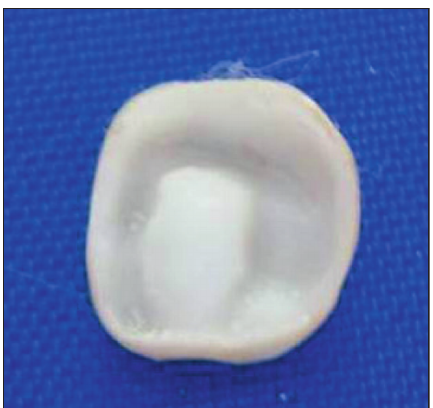
Figure 4: Tissue surface depicting the core and crown fabricated as a single